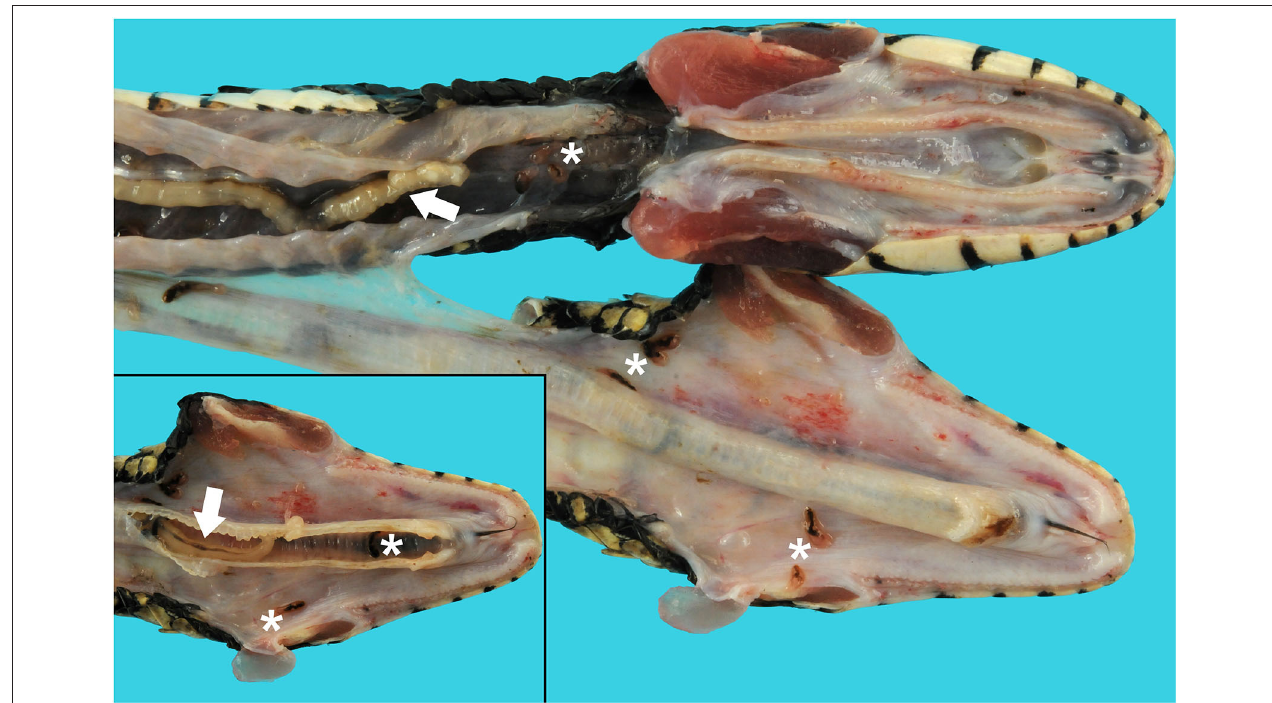
FIGURE 1 | Tracheal and esophageal pentastomes and trematodes in a banded water snake ( Nerodia fasciata ). The jaw is unilaterally disarticulated and positioned laterally to expose the oral cavity, glottis, and esophagus. Raillietiella orientalis pentastomes (white arrows) and Ochetosoma sp. trematodes (white asterisks) are present in the oral cavity, esophagus, and lumen of the trachea